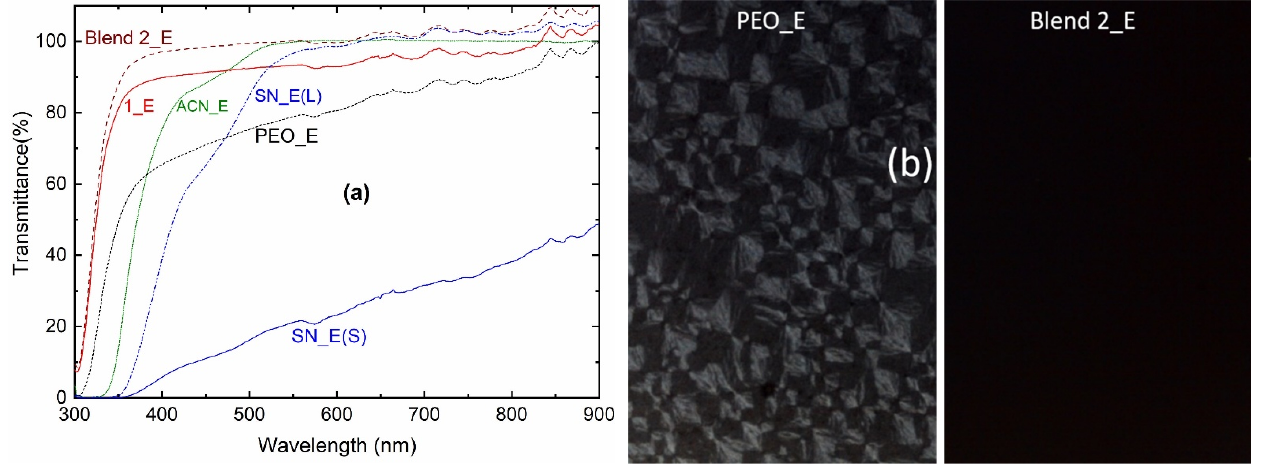
Figure 7. ( a ) Transmittance spectra of the ACN_E, SN_E (L, liquid; S, solid), PEO_E, Blend 1_E, and Blend 2_E. ( b ) polarized optical micrographs of the PEO_E and Blend 2_E.